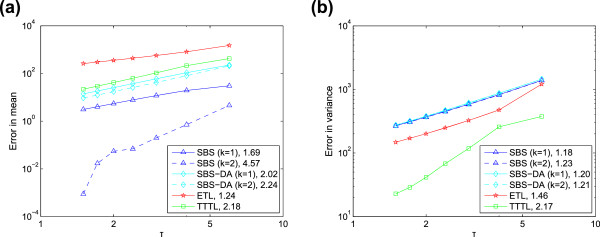
Order of accuracy for non-linear system. Error versus stepsize for
(a) mean, and (b) variance of the non-linear system
X+Y→∅, with
c=10−5,
X(0)=[10000,10000]T,T=12. The
gradients of linear regression lines fitted to the points are shown in the
legend. The first three points of the SBS with k=2 are omitted from
the regression line, as they are clearly affected by Monte Carlo error.